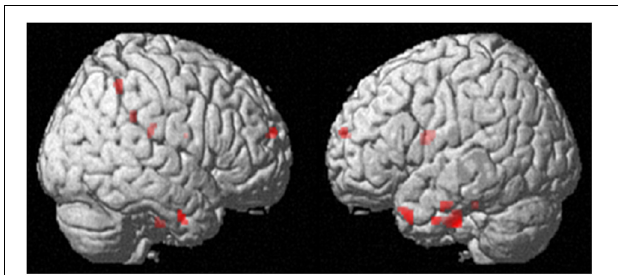
FIGURE 5 | Interpersonal emotion regulation (interpersonal reappraisal & suppression vs. watch), p < 0 . 001 uncorrected, extent threshold = 10 voxels.